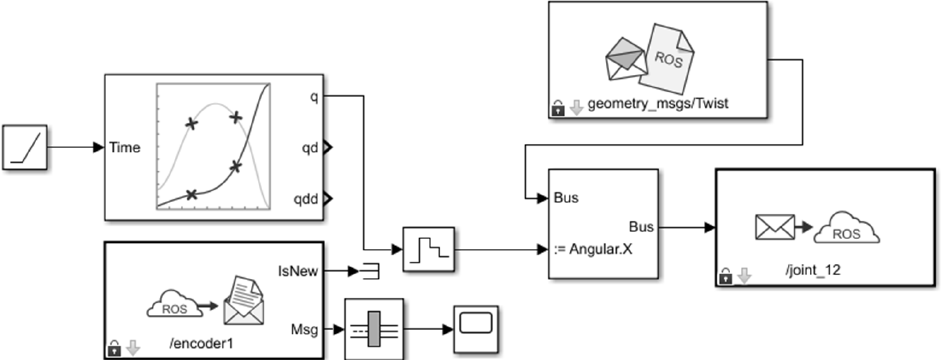
Figure 20. ROS nodes which were added in MATLAB–Simulink.